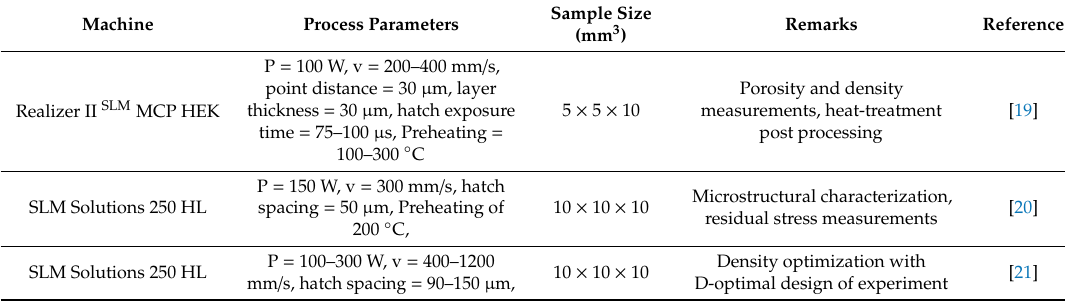
Table 1. Important research activities around H13 tool